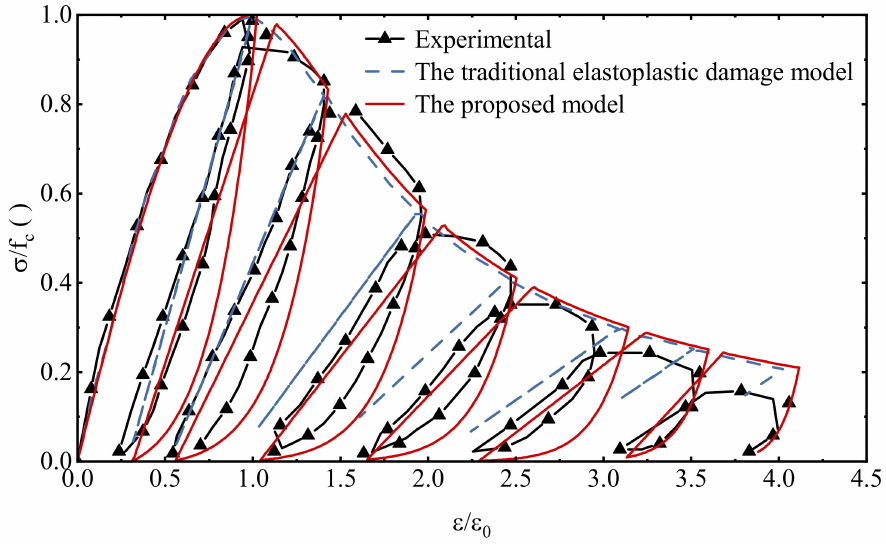
Figure 13. Comparison of stress − strain relationship under uniaxial cyclic compressive loading.